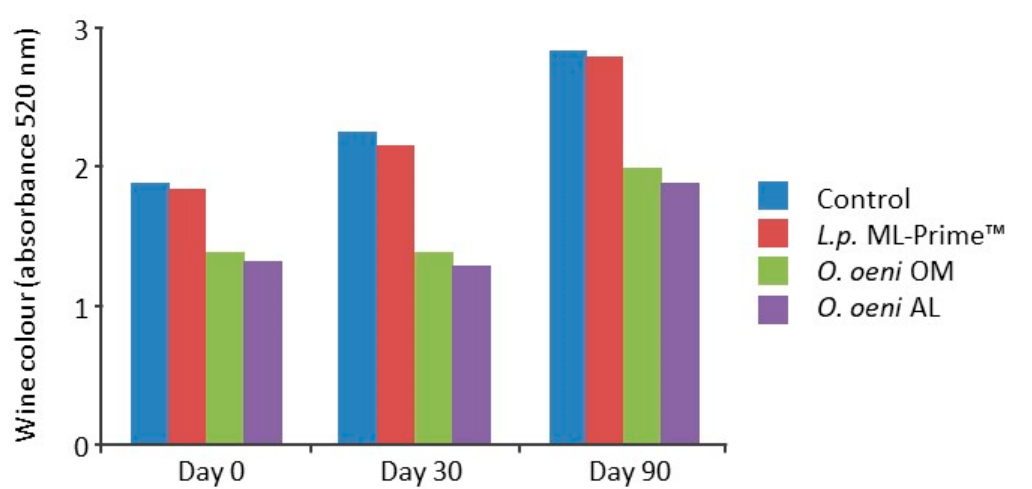
Figure 6. Wine color (520 nm) of Pinot noir wine that did not undergo MLF (Control) or MLF with different malolactic bacteria strains; the wines were stored at 13 ° C and extracted from Bartowsky and Krieger-Weber [75].